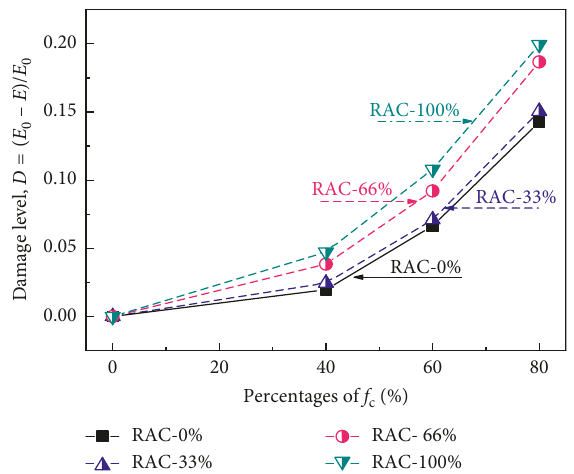
Figure 7: Damage level of RAC after being subjected to various loading